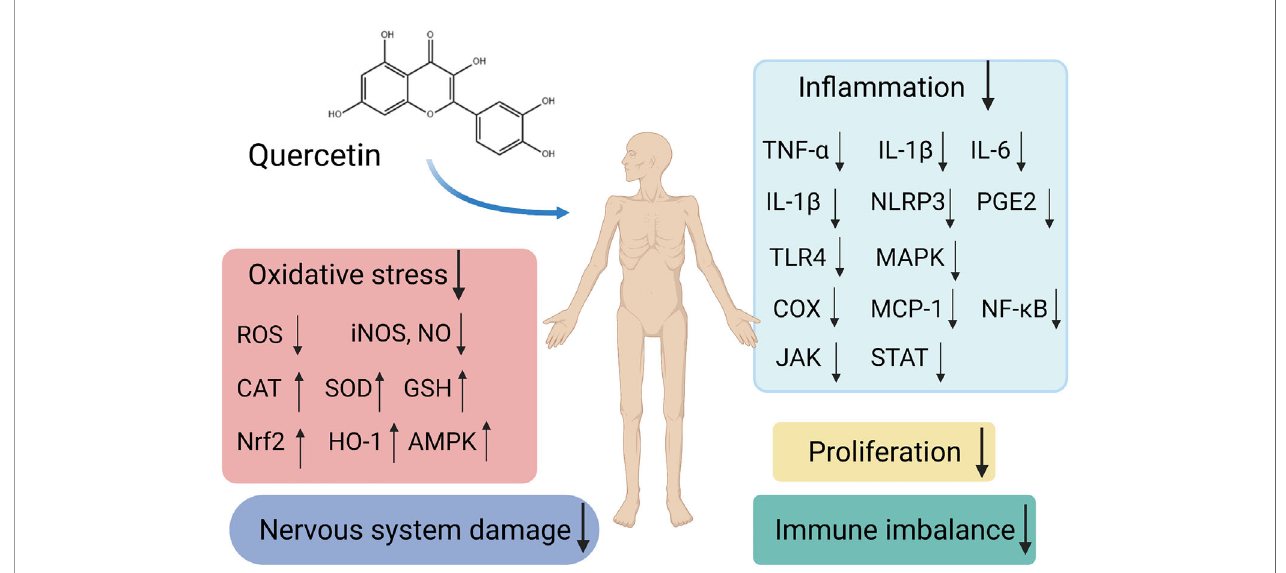
FIGURE 1 | Schematic representation of different signaling pathways and targets by quercetin as a potential therapeutic strategy in autoimmune